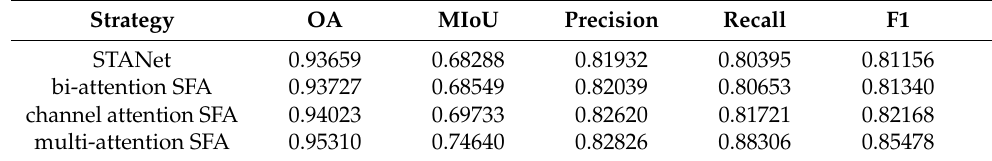
Table 8. The experiment results on the SZTAKI dataset with four strategies.